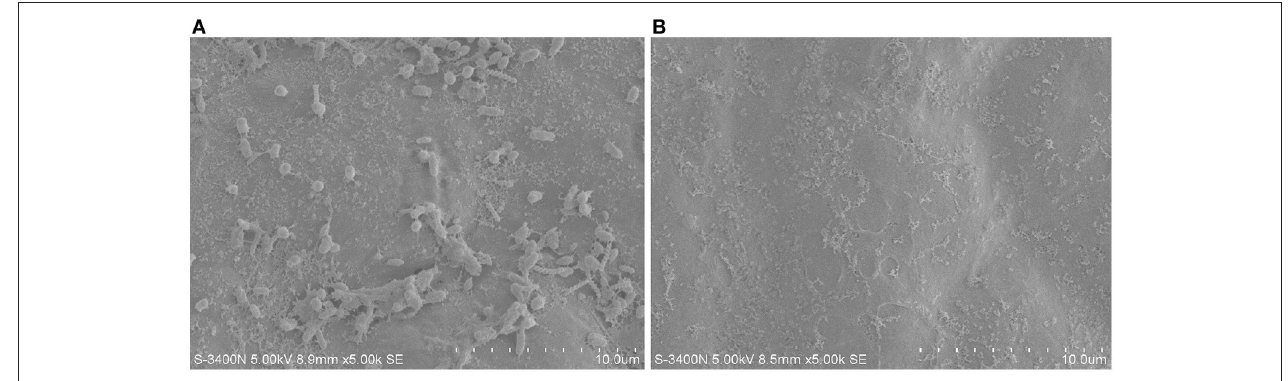
FIGURE 1 | The epiphytes removal effect of ethanol plus bleach sterilization using SEM. (A) Untreated U. prolifera . (B) Ehtanol plus bleach treated U. prolfiera .